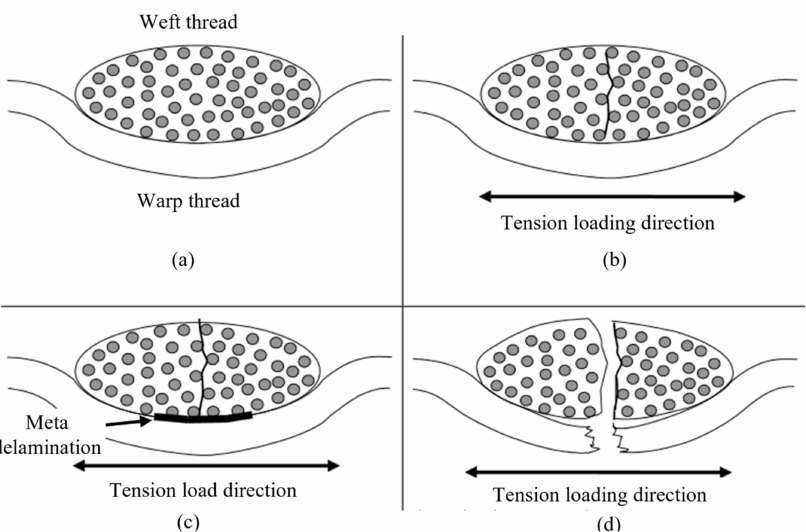
Figure 2. Gradual development of textile composite damage due to fatigue: ( a ) initial phase–no failure due to fatigue; ( b ) first damage phase – delamination of weft threads and the matrix, transverse cracking; ( c ) second damage phase – delamination spreads between weft threads and the matrix, meta delamination between weft and warp threads; ( d ) third damage phase – crack propagation from weft to warp threads and fatigue fracture occurs